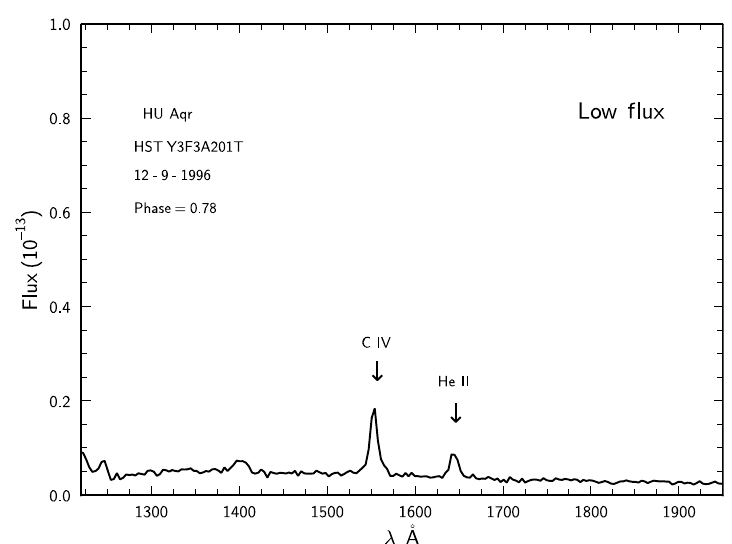
Fig. 5. IUE Spectrum of HU Aqr with low (cid:13)ux at phase 0.78. The (cid:13)ux is plotted in units of erg cm (cid:0) 2 s (cid:0) 1 (cid:23)A (cid:0) 1 .